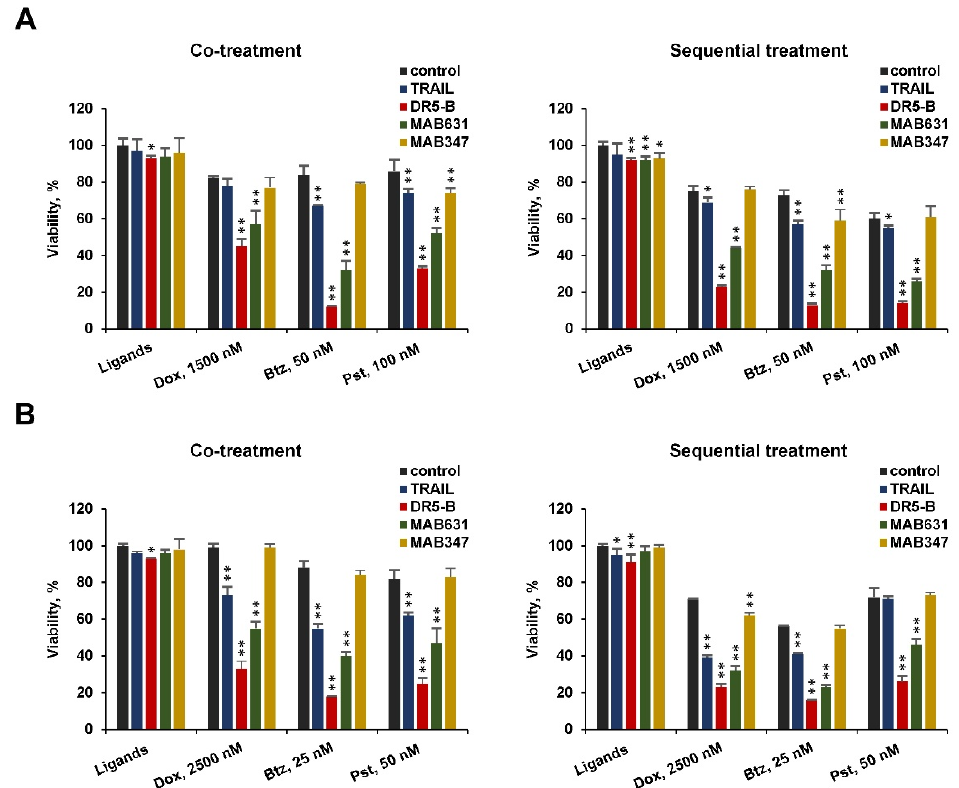
Figure 7. Chemotherapeutic agents sensitize TRAIL-resistant cancer cells to TRAIL mainly by activating DR5 mediated signaling. In co-treatment experiments, A549 ( A ) and HT-29 ( B ) cells were incubated with 1000 ng / mL of TRAIL, DR5-B or with 1000 ng / mL of agonistic antibodies to DR5 (MAB631) or to DR4 (MAB347) in combination with doxorubicin (Dox), bortezomib (Btz) and panobinostat (Pst) at the indicated concentrations for 24 h. In a sequential treatment mode, cells were pretreated with the chemotherapeutic agents for 24 h, followed by treatment with the ligands for another 24 h. Cell viability was quantified by Wst-1 assay. Mean ± Standard Deviation ( n = 4). The asterisks indicate significance (* p < 0.05) and (** p < 0.001) relative to control cells or cells treated with chemotherapy without ligands.